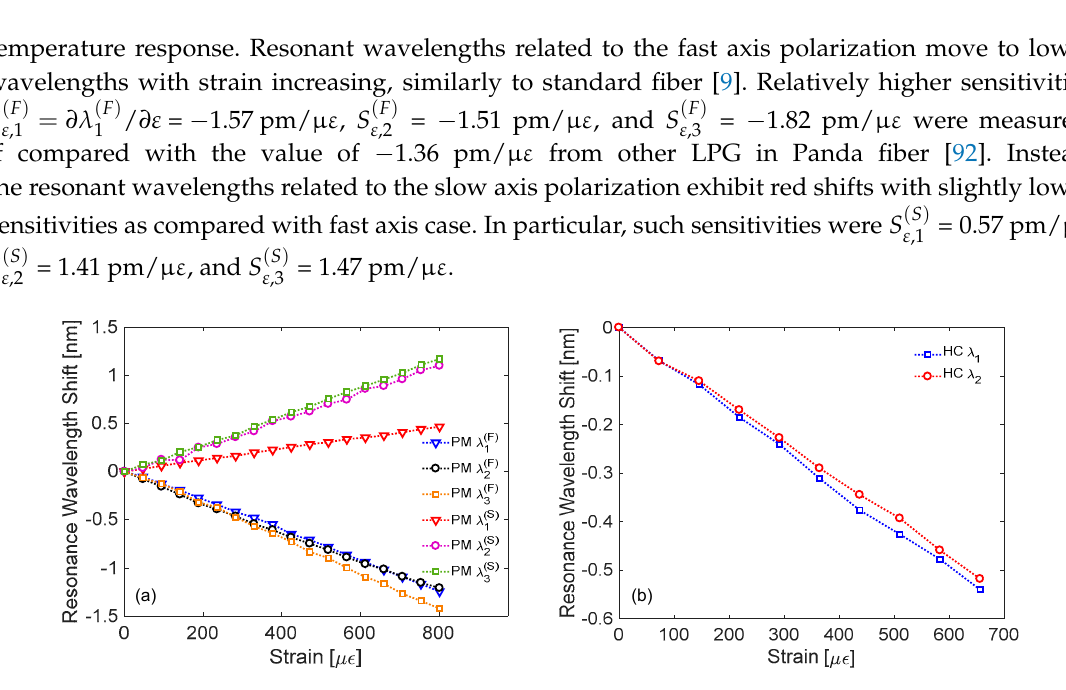
Figure 10. Resonance wavelength shifts towards strain for LPGs in: ( a ) polarization-maintaining Panda fiber; ( b ) Hollow-core fiber.